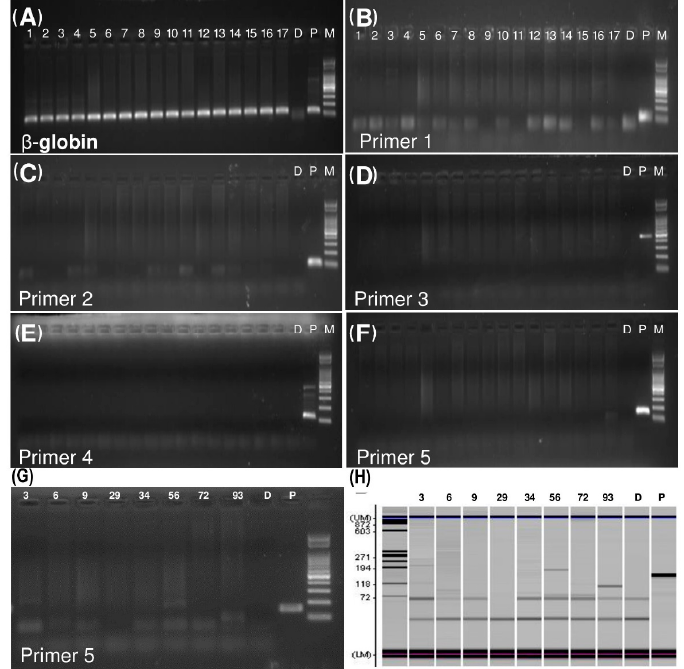
Figure 1. C. psittaci detection by polymerase chain reaction (PCR) in ocular adnexal MALT lym ‐ phoma tissues. ( A ) The DNA quality of the samples was adequate, as shown by clear beta ‐ globin bands. ( B – F ) There is a clear single band in each positive control column, but there is no other am ‐ plified PCR product in the other tissue sample columns. ( G ) In the initial PCR test, a few samples showed ambiguous bands near the level of the positive control DNA. ( H ) The ambiguous bands were confirmed negative when observed using a high ‐ resolution device. (D, distilled water as a negative control; P, positive control; M, DNA size standard ladder).